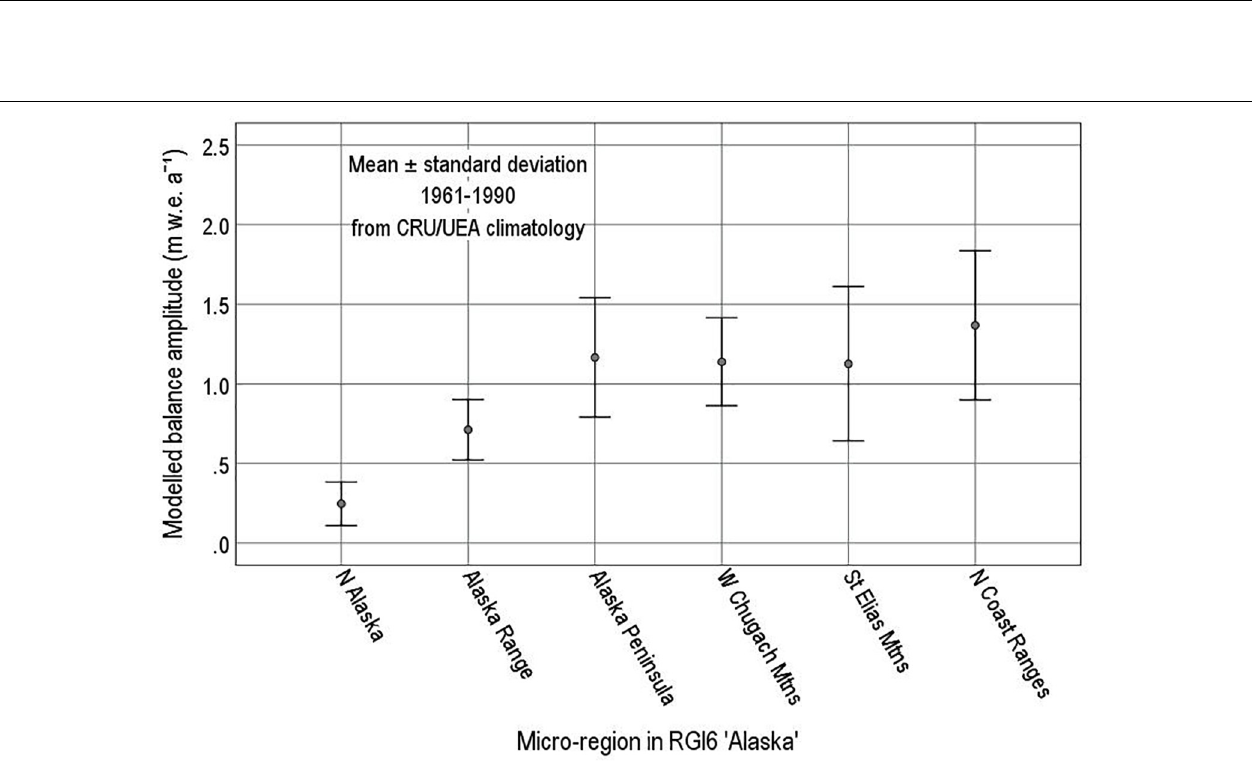
Frontiers in Earth Science |